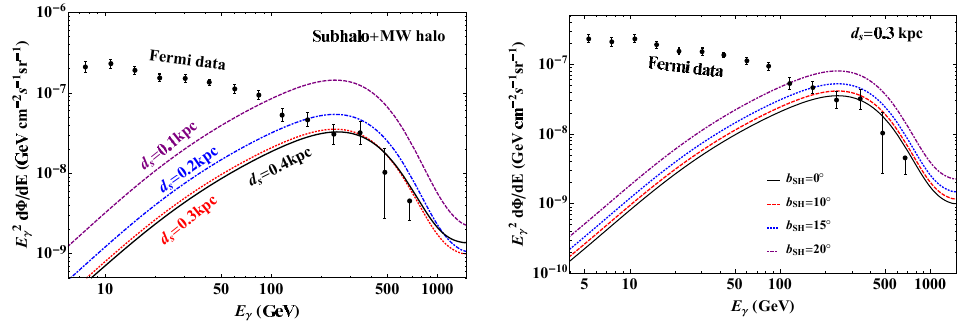
Figure 9 . Left panel: Fermi IGRB data [61] and gamma rays from DM where V 1 is electrophilic and V 2 is L (cid:22) (cid:0) L (cid:28) gauged, with di(cid:11)erent d s values: d s = (0 : 1 ; 0 : 2 ; 0 : 3 ; 0 : 4) kpc. The subhalo is placed at b SH = 0 (cid:14) . Right panel: same as the left panel except that we keep d s = 0 : 3 kpc (cid:12)xed and let b SH vary: b SH = (0 (cid:14) ; 10 (cid:14) ; 15 (cid:14) ; 20 (cid:14) ).